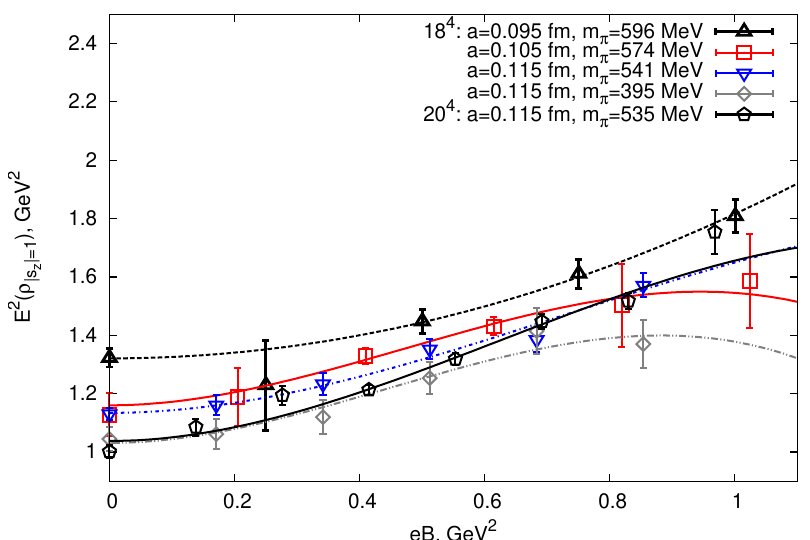
Figure 7 . The energy squared of the (cid:26) 0 ( j s z j = 1) meson versus magnetic (cid:12)eld for various lattice spacings, pion masses, and two lattice volumes 18 4 and 20 4 . The lines correspond to the (cid:12)ts of the lattice data obtained using formula (6.2).